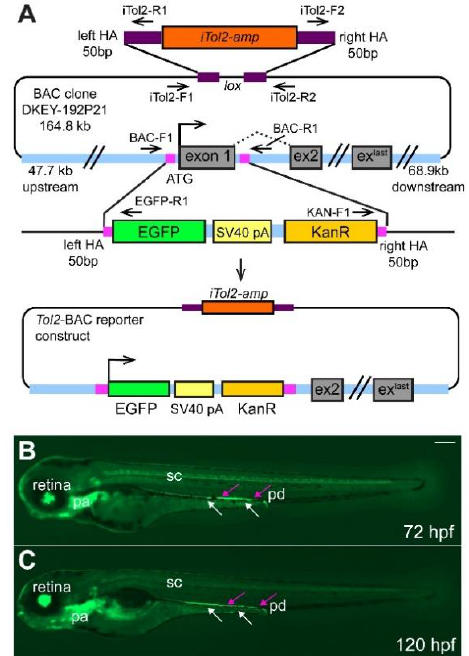
Figure 1. Overview of BAC-construct cloning strategy. ( A ) The start codon and exon 1 of ret were replaced by homologous recombination with the EGFP-SV40-pA-KanR construct using 50 bp-long homology arms (HA, magenta box) as indicated. iTol2 sites were included in the BAC backbone as shown using homologous recombination. The arrows indicate forward and reverse primer pairs to verify the correct generation of the tol2-BAC reporter construct. Integration of the BAC DNA does not result in overexpression of ret as the ret ATG is replaced by the EGFP cassette and the EGFP insert contains a strong transcription termination signal (SV40 pA, simian virus 40 poly A) [30]. Overview of GFP + cells in the retina, pharyngeal arches (pa), spinal cord (sc), pronephric duct (pd, magenta arrows), and ENS cells (white arrows) at 72 ( B ) and 120 ( C ) hours post fertilization (hpf). ( B , C ): Whole-mount side-views of embryo/larva at the stage indicated. KanR kanamycin. Scale bar = 200 µ